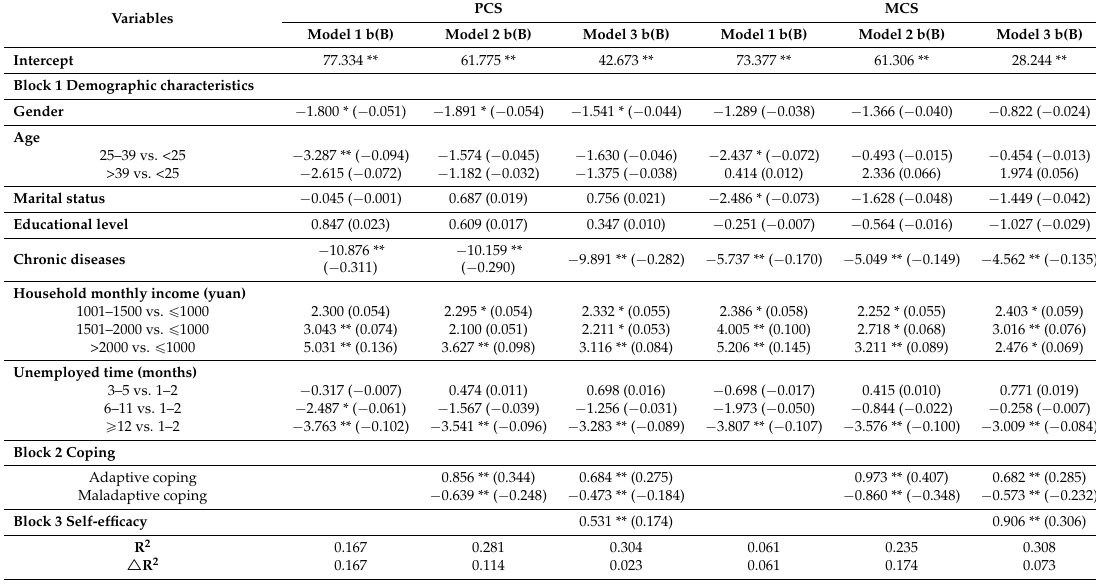
Table 4. The hierarchical multiple regression models of PCS and